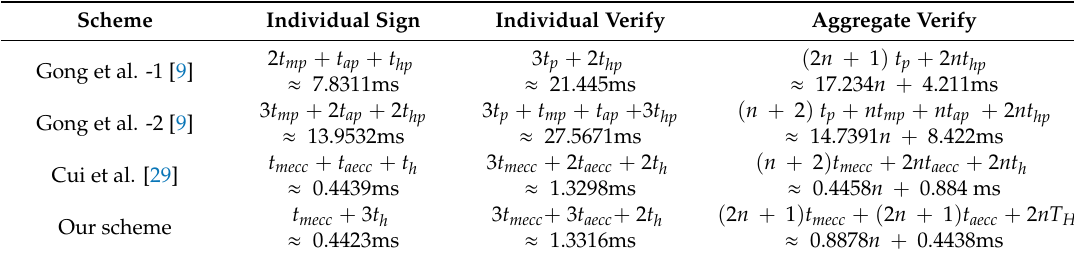
Table 5. The comparison of computation